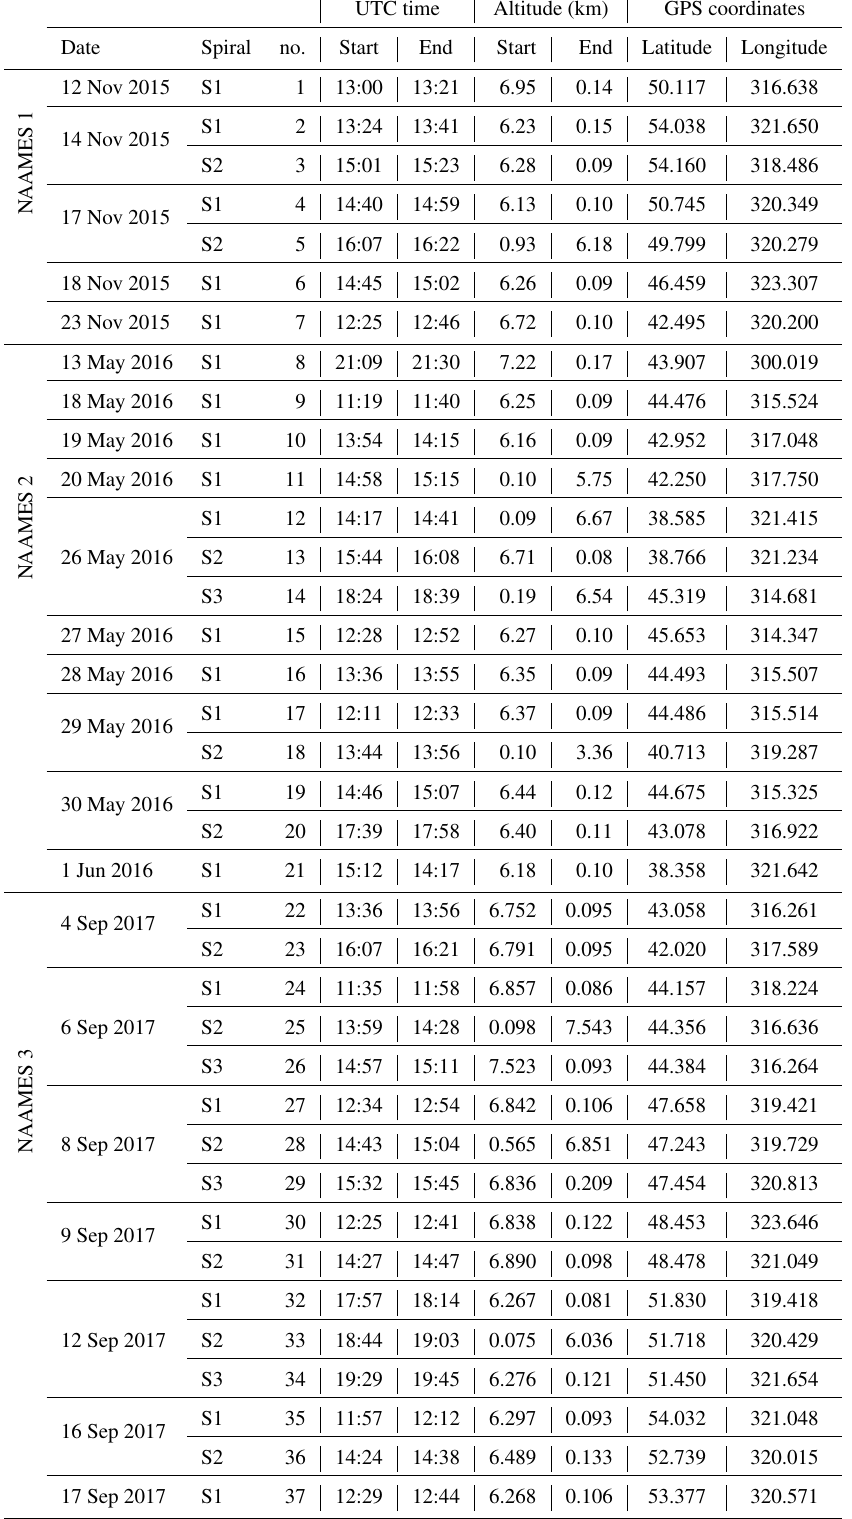
Table 1. UTC interval times, minimum and maximum altitude ranges, and geographical coordinates of the C-130 spirals analyzed in this